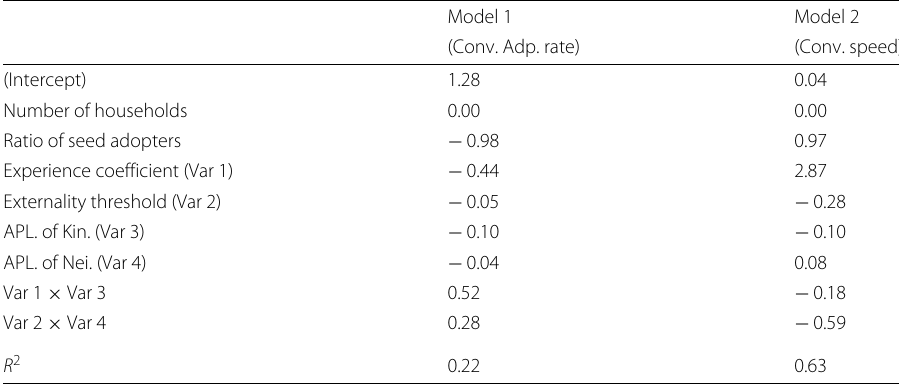
Table 9 Regressions of convergence adoption rate and convergence speed on average path length (negative externality